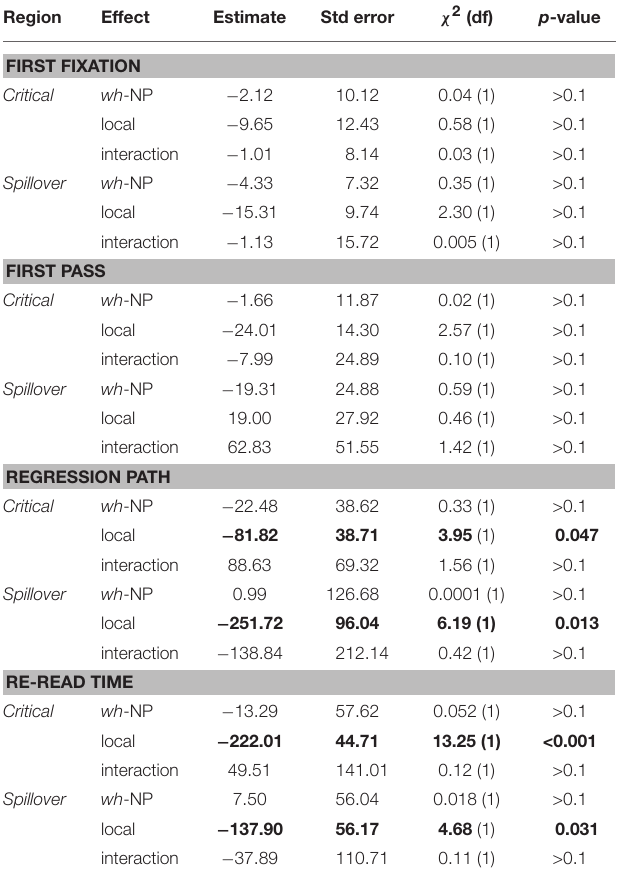
TABLE 8 | Combined ANOVA and LME results for Experiment 4. Region